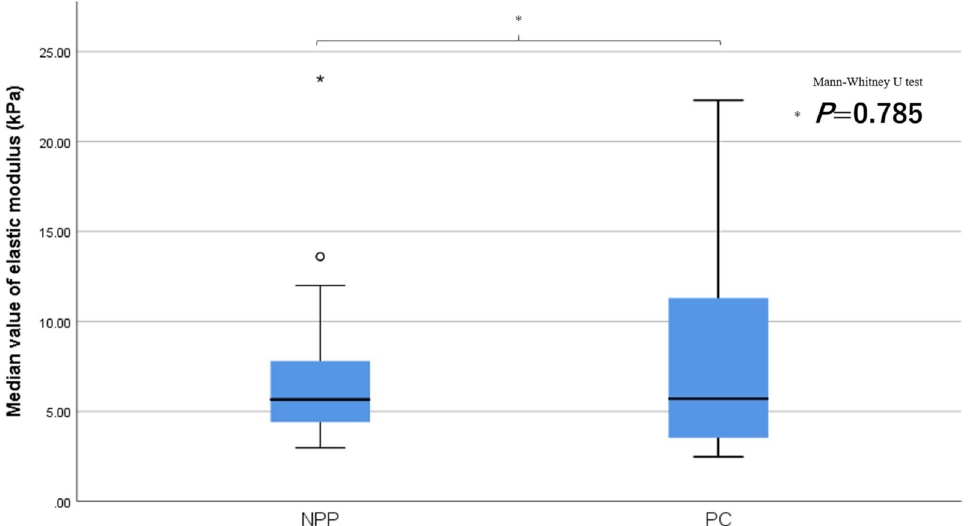
Figure 2. Comparison of elastic modulus between normal pancreatic parenchyma (NPP) group and pancreatic cancer (PC) group. The median values of each group are compared using a t-test, and the error bars show interquartile